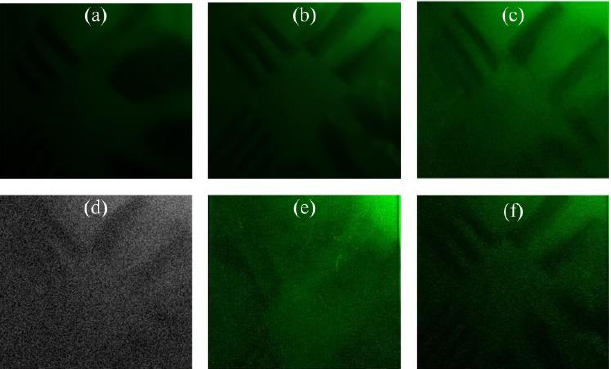
Figure 5. Restoration and reconstruction results: ( a ) result of BD; ( b ) result of POCS; ( c ) result of M − SB; ( d ) result of M − TV; ( e ) result of PIV − RR; ( f ) result of the proposed method in this paper. Table 3. Comparison of evaluation results.